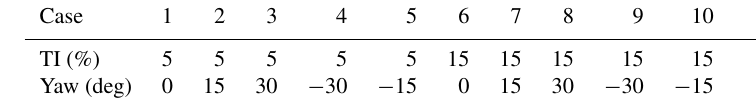
Table 3. High-fidelity simulation cases. Different yaw angles are used to evaluate the precision of BEM versus free vortex model.